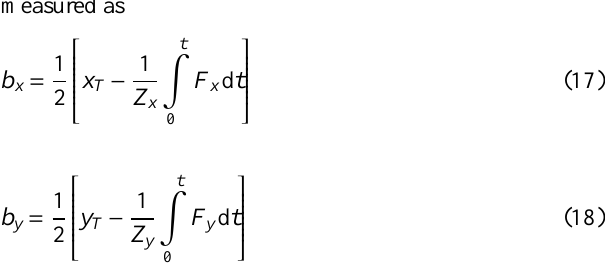
Figure 4: WBC plan for gantry crane with planar-moving trolley